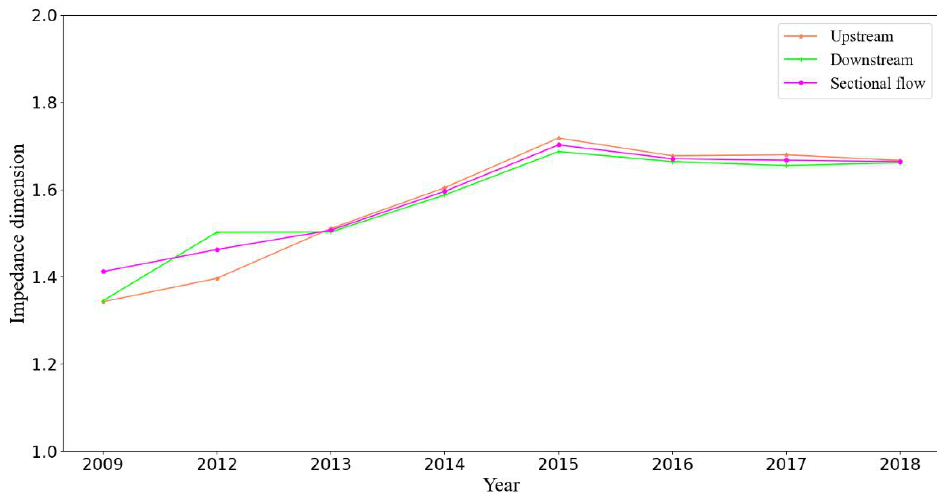
Figure 8. Impedance dimension with demand as a weight.